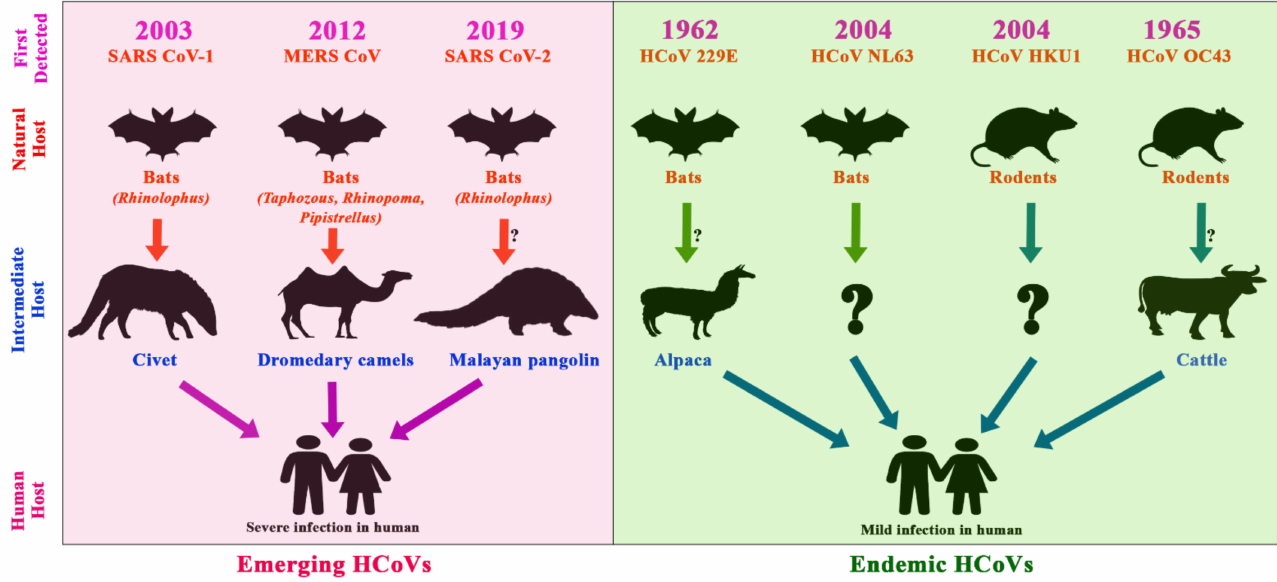
Figure 5. Timeline of the emergence of human CoVs, their reservoirs, and intermediate hosts; the pink shaded area depicts emerging coronaviruses, whereas the green shaded area depicts the endemic coronaviruses. The arrows show the transmission route of the viruses from animal to human through intermediate